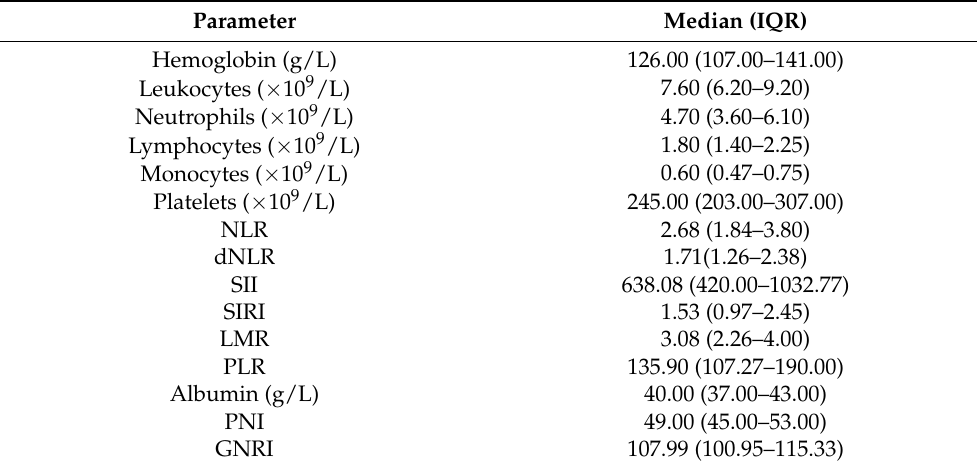
Table 2. Values of laboratory, nutritional, and inflammatory parameters.